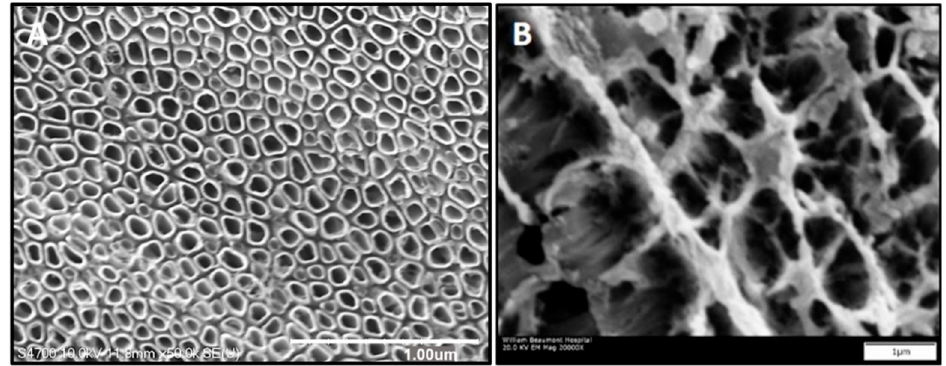
Figure 1. Aligned titanium nanotubes (TiNT) ( A ) and trabecular TiNT ( B ) surfaces. ( A , B ) Scale Bar: 1 μ m.